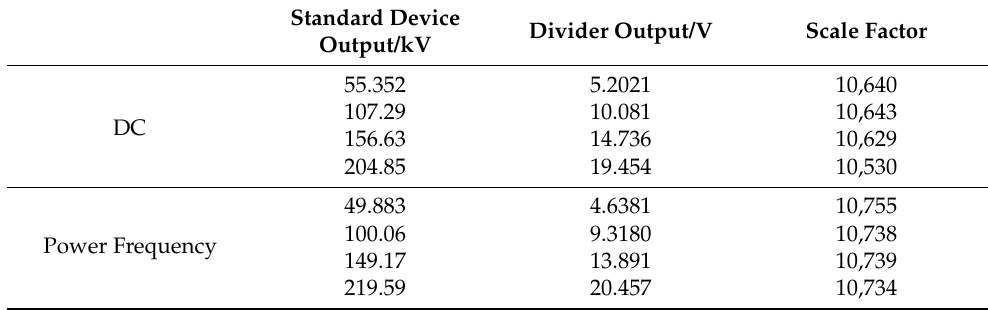
Table 6. Test results at 40 ◦ C.